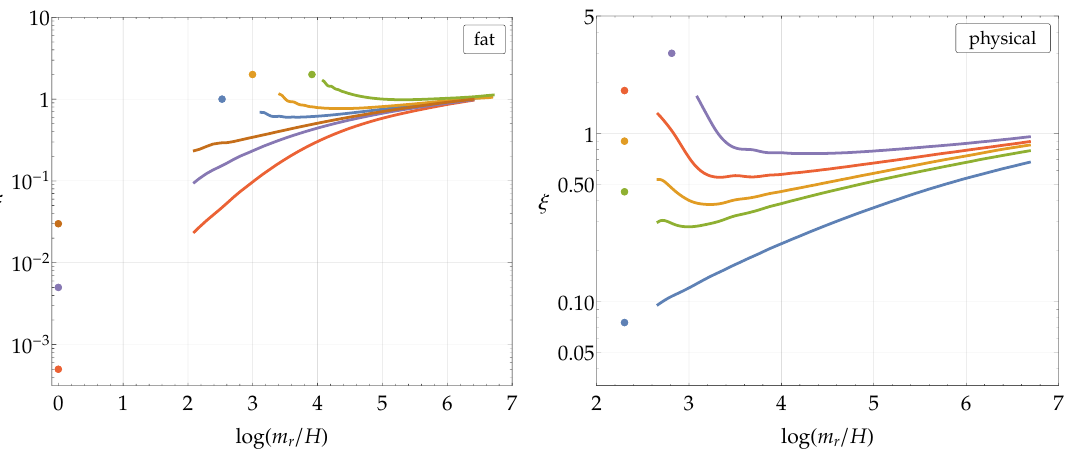
Figure 2 . The evolution of the average number of strings per Hubble patch (cid:24) ( t ) as a function of time (here represented by Hubble) using the fat string trick (for which m r / t (cid:0) 1 = 2 , left) and for the physical case ( m r = const, right) for di(cid:11)erent initial conditions. Each curve corresponds to the average of many simulations with the same initial value of (cid:24) . The position of the coloured dots indi- cates the initial time and the value of (cid:24) for each simulation set. The number of simulations has been taken large enough that the statistical uncertainties are smaller than the thickness of the